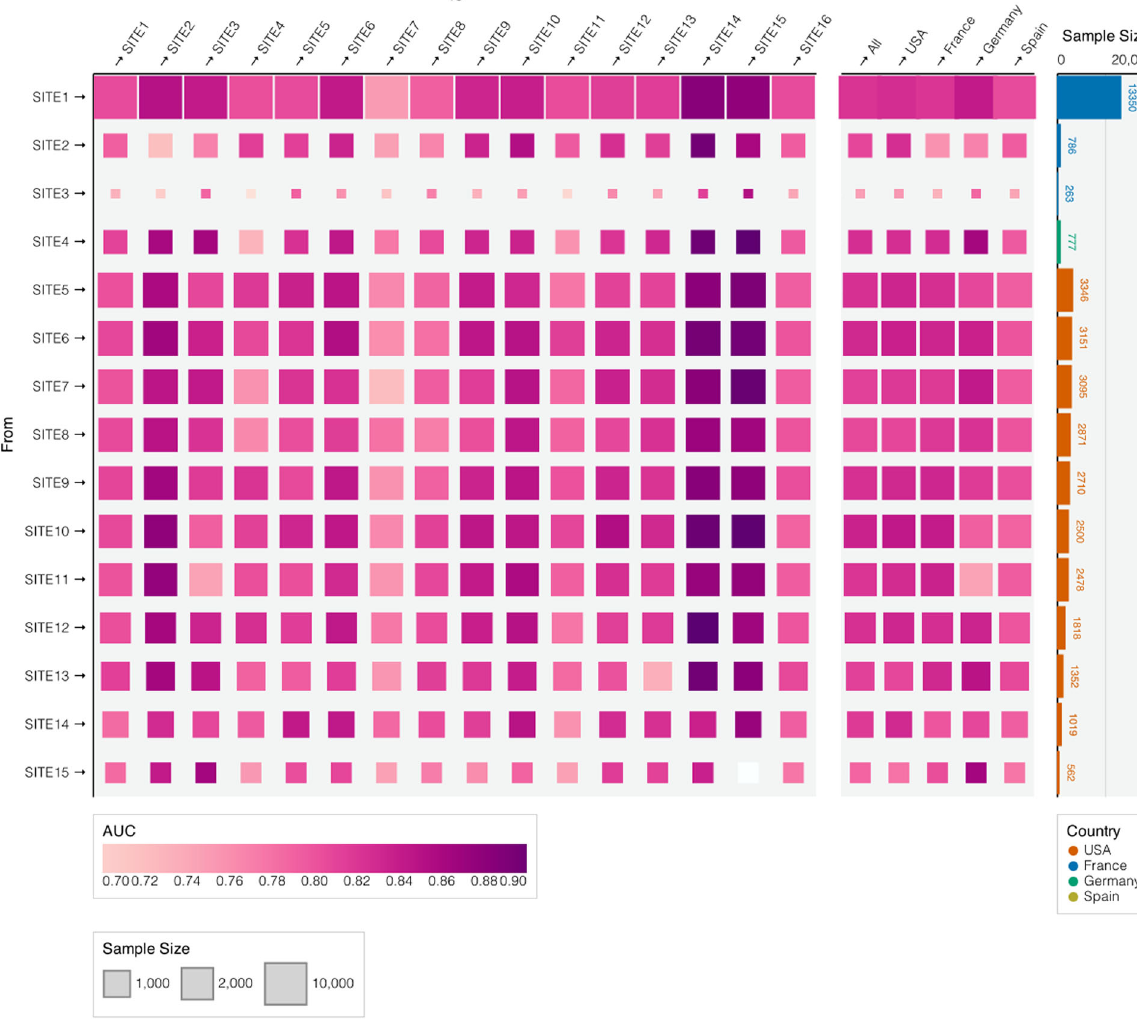
Fig. 3 Transportability of the Mortality Prediction Model Across Sites and Countries. Heatmap of transportability of the Cox regression model across different sites and countries. Each part of the fi gure represents performance when the model is trained at one site and evaluated at